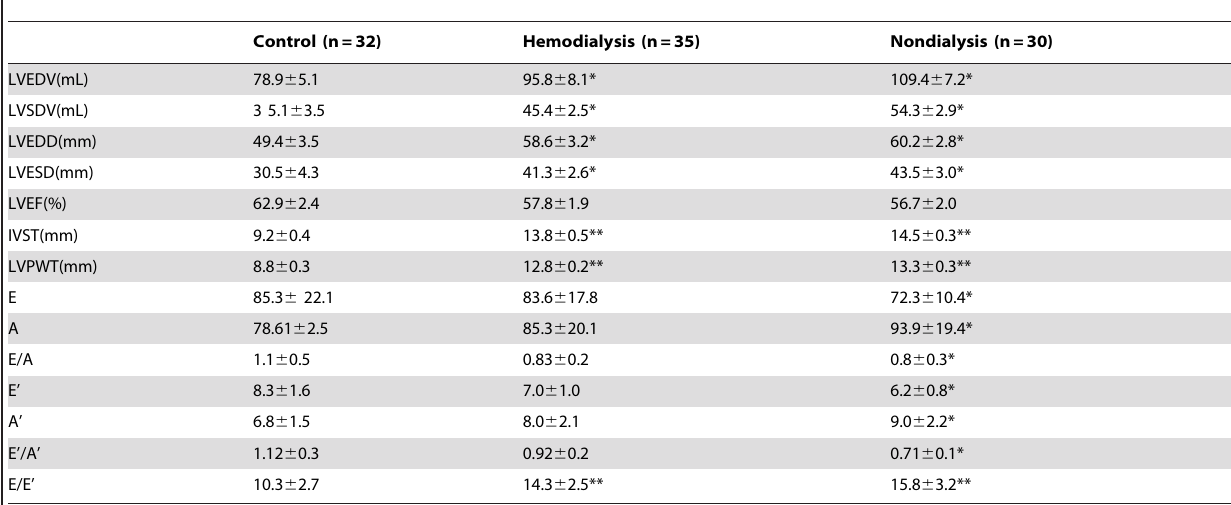
Table 2. Echocardiographic Characteristics of the Uremia and Control Groups.